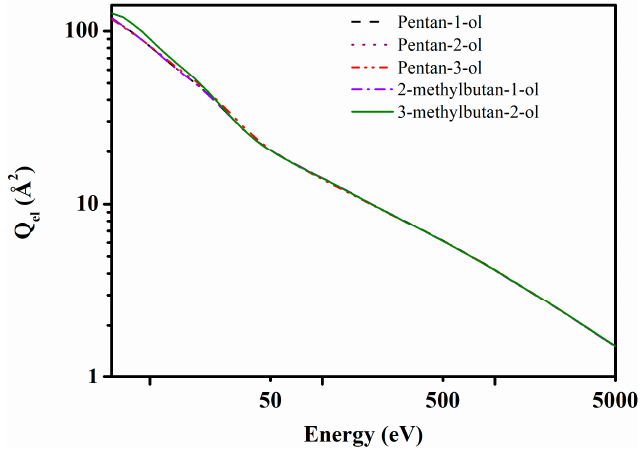
Figure 3. Elastic cross-section of pentan-1-ol: solid black line shows present results, dashed blue line displays results by de Oliviera et al. and dash-dot red line represents results by Bhardvaja et al.